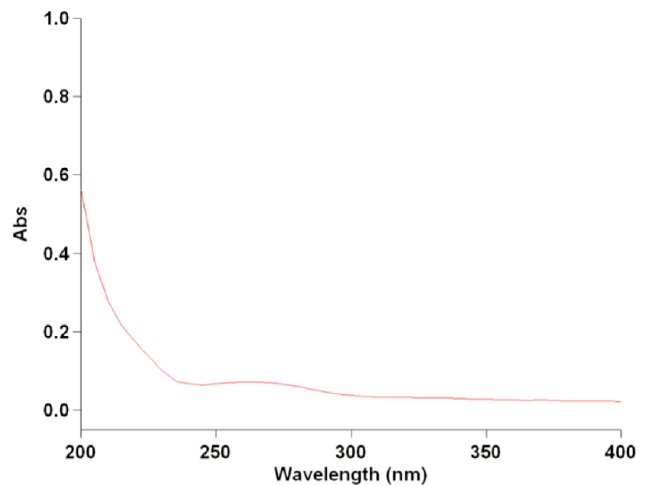
Figure 3. UV-visible absorption spectrum for MOE6-EPS in the range of (200–400 nm).